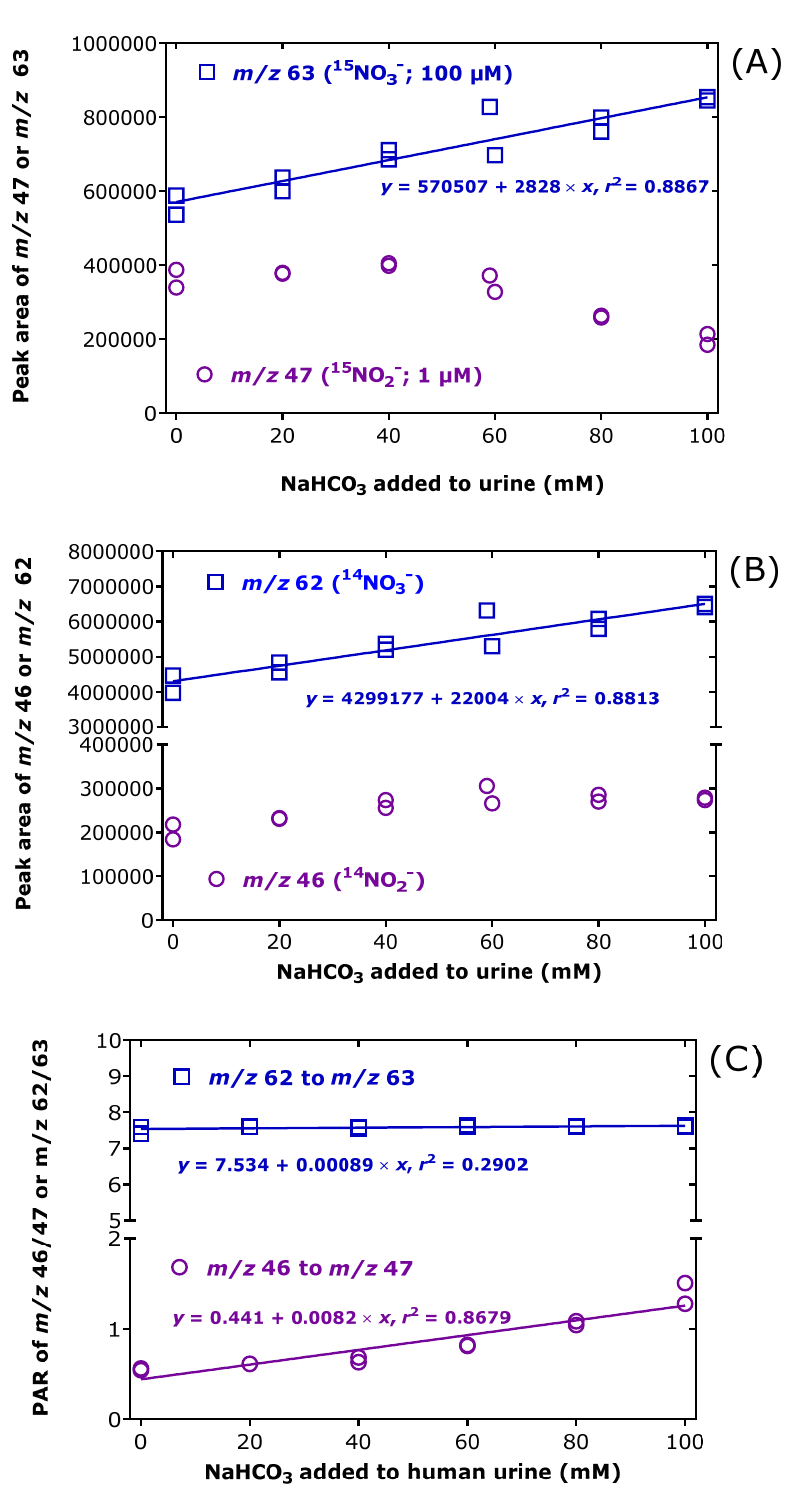
Figure 2. Plots of the peak area of ( A ) m / z 63 for [ 15 N]nitrate and m / z 47 for [ 15 N]nitrite, of ( B ) m / z 62 for [ 14 N]nitrate and m / z 46 for [ 14 N]nitrite in a human urine sample spiked with the indicated bicarbonate concentrations, and of ( C ) the peak area ratio (PAR) of m / z 62 to m / z 63 for nitrate and of m / z 46 to m / z 47 for nitrite. The added concentrations were 100 µ M for [ 15 N]nitrate and 1 µ M for [ 15 N]nitrite. Data are shown from two independent experiments. The derivatization time with PFB-Br was each 60 min.